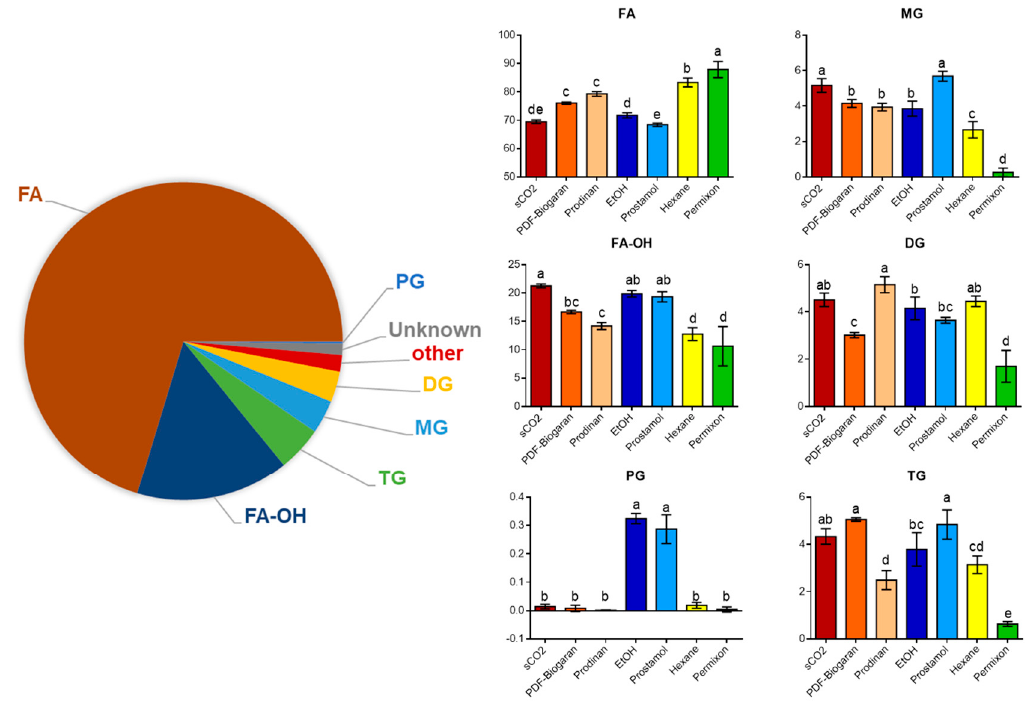
Figure 2. The mean relative content of the main chemical classes for all SrE samples (left, pie chart) and for each sample group (right, bar plots) according to identified features from the LC-MS dataset. ANOVA and Tukey’s post-hoc test (DF = 6.24; p ≤ 0.01) were used to assess significant di ff